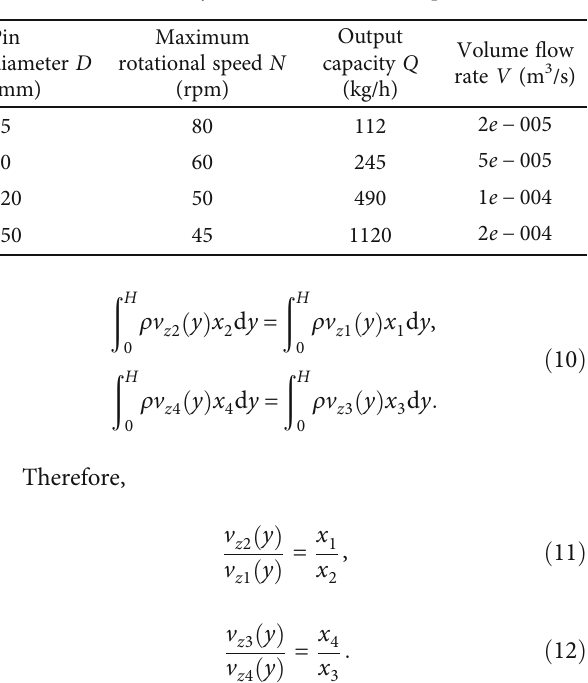
Table 3: Boundary conditions and motion parameters.